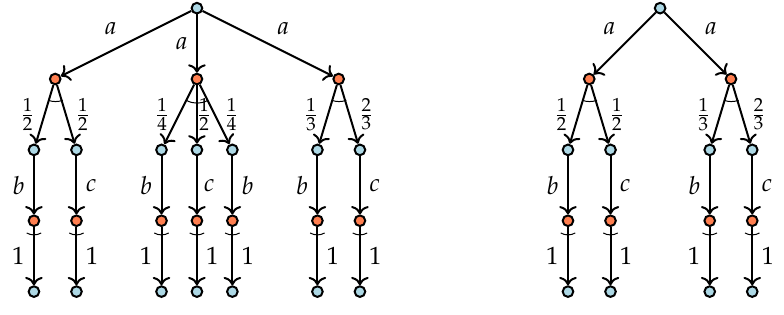
Figure 1. Two probabilistically bisimilar nondeterministic transition